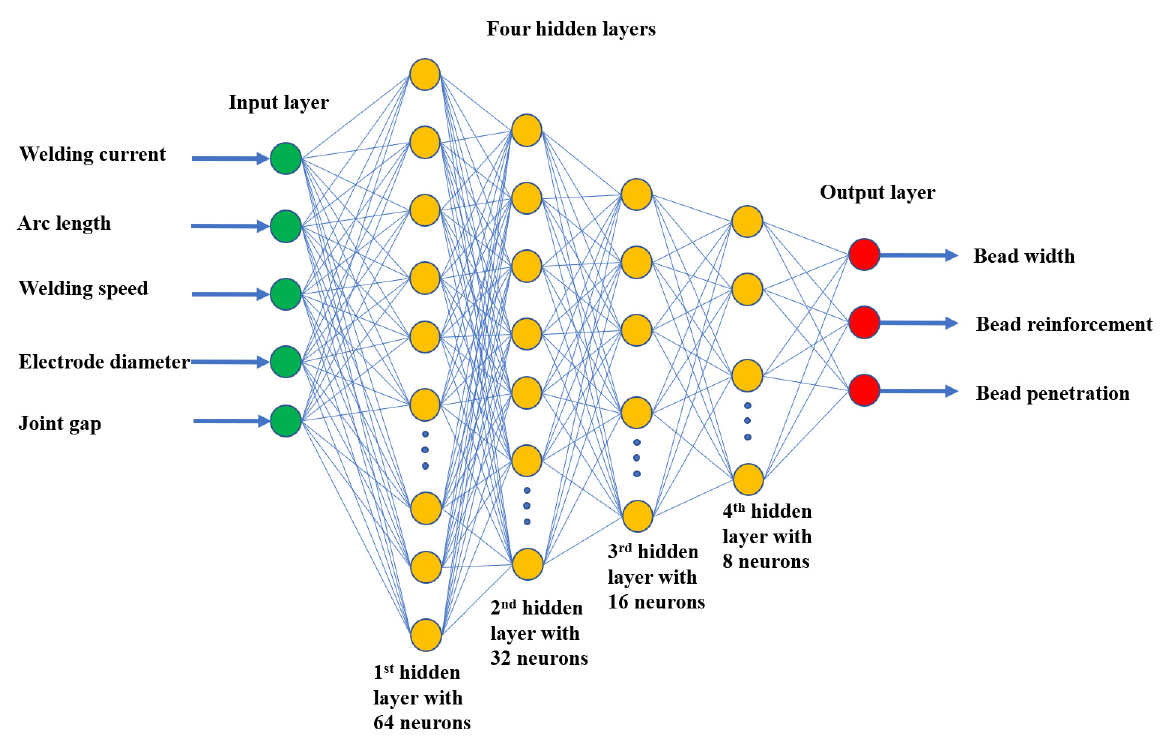
Figure 7. Deep learning neural network architecture for the SMAW welding process.